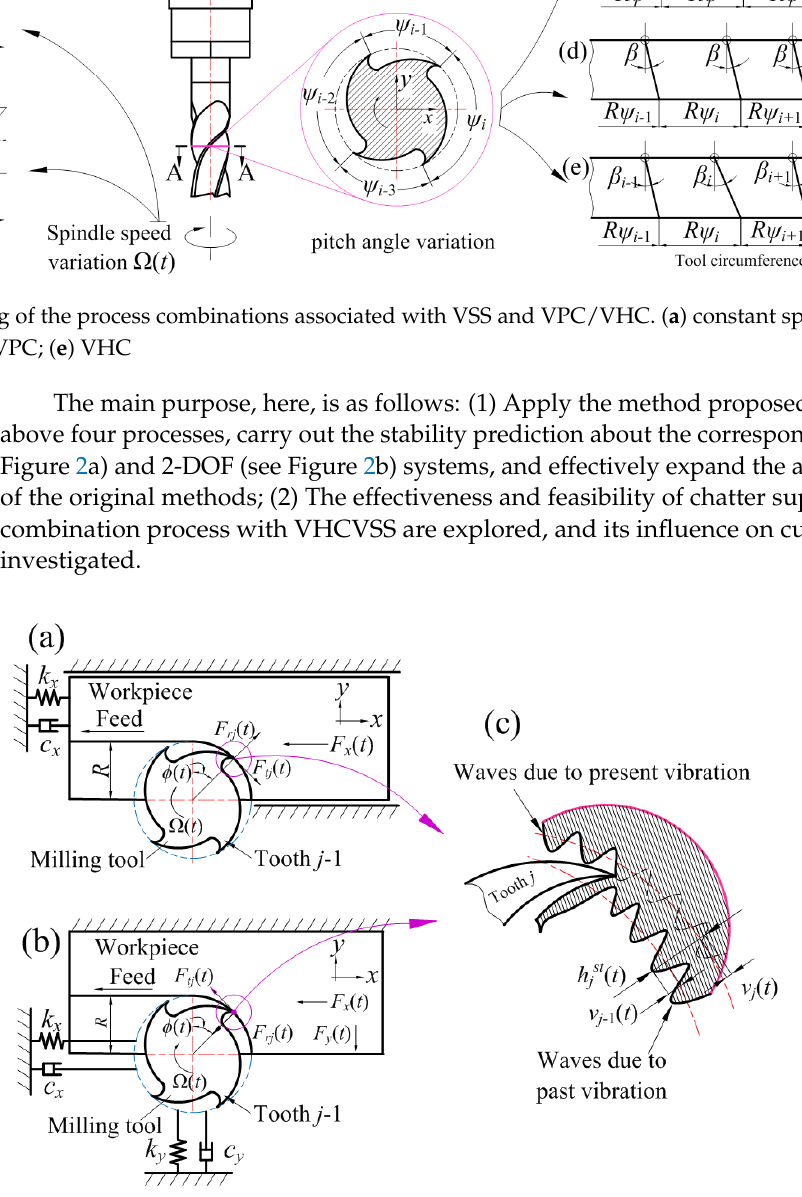
Figure 2. Schematic mechanical model of the milling system [7]. ( a ) 1-DOF; ( b ) 2-DOF; ( c ) regeneration effect.